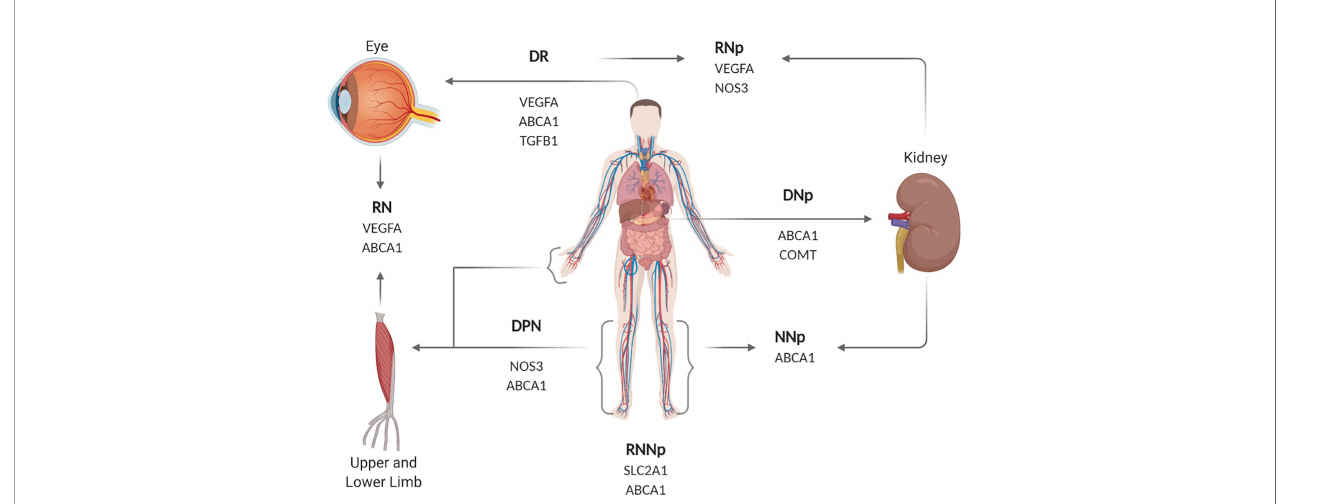
FIGURE 1 | Diagram showing the genes associated with the different complications, highlighting which area of the human body they affect. DPN, diabetic peripheral neuropathy; DNp, diabetic nephropathy; DR, diabetic retinopathy; DPN/DNp, diabetic peripheral neuropathy and nephropathy; DR/DPN, diabetic retinopathy and peripheral neuropathy, DR/DNp, diabetic retinopathy and nephropathy; DR/DPN/DNp, diabetic retinopathy, peripheral neuropathy and nephropathy. SLC2A1, Solute Carrier Family 2 Member 1; VEGFA, Vascular endothelial growth factor A; NOS3, Nitric Oxide Synthase 3; ABCA1, ATP Binding Cassette Subfamily A Member 1;